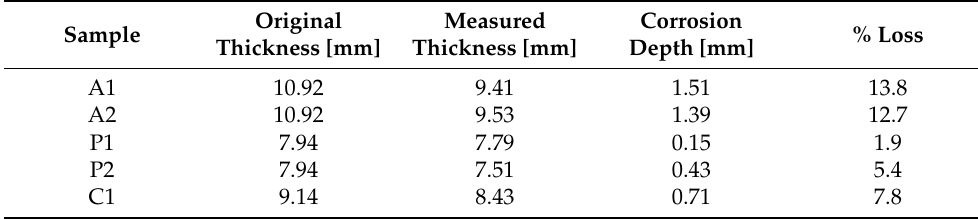
Figure 13. Sample before and after rust removal. Table 5. Corrosion depth measurements.